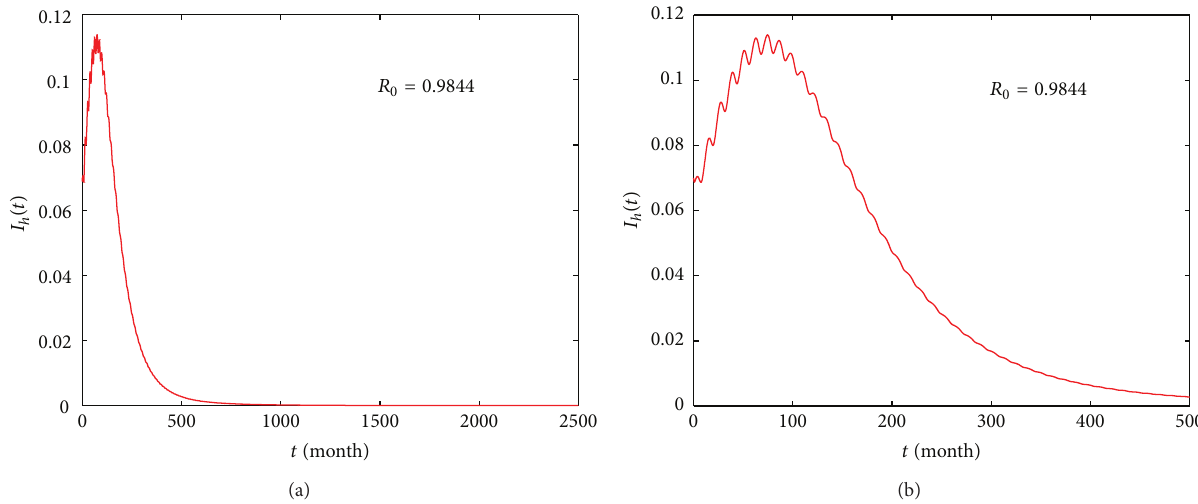
Figure 1: Graphs of numerical simulations of (1) showings the tendency of the infected citrus population. (a) 𝑡 ∈ [0,2500] ; (b) 𝑡 ∈ [0, 500] .